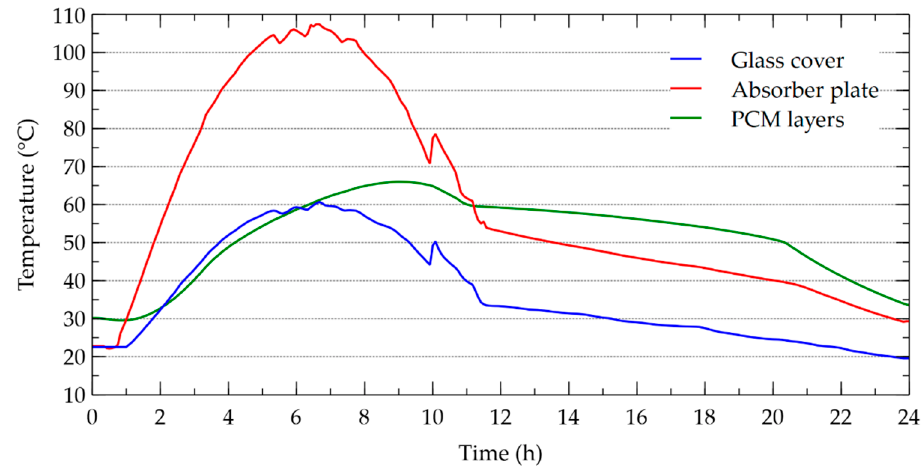
Figure 9. Estimated temperatures of components in case 1.